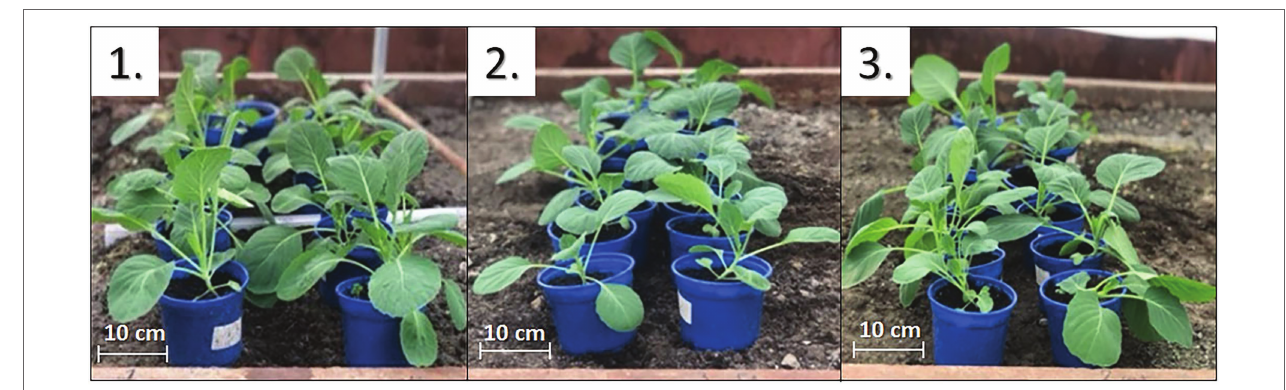
FIGURE 4 | Cabbage plants grown for 33 days under different agrotextiles, photos 1–3 correspond to plants grown under agrotextiles: 1—PP + PLA + LUM; 2— PP + PLA; and 3—PP + PLA +